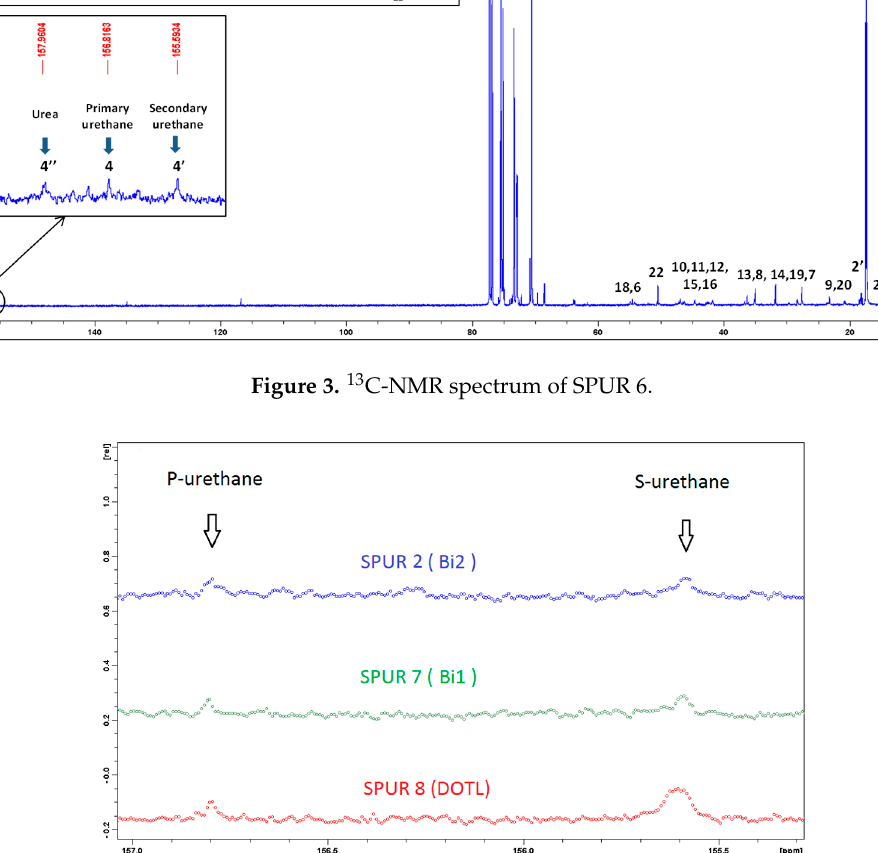
Figure 4. The expanded 13 C-NMR spectra (155–157 ppm) for samples with different catalysts.